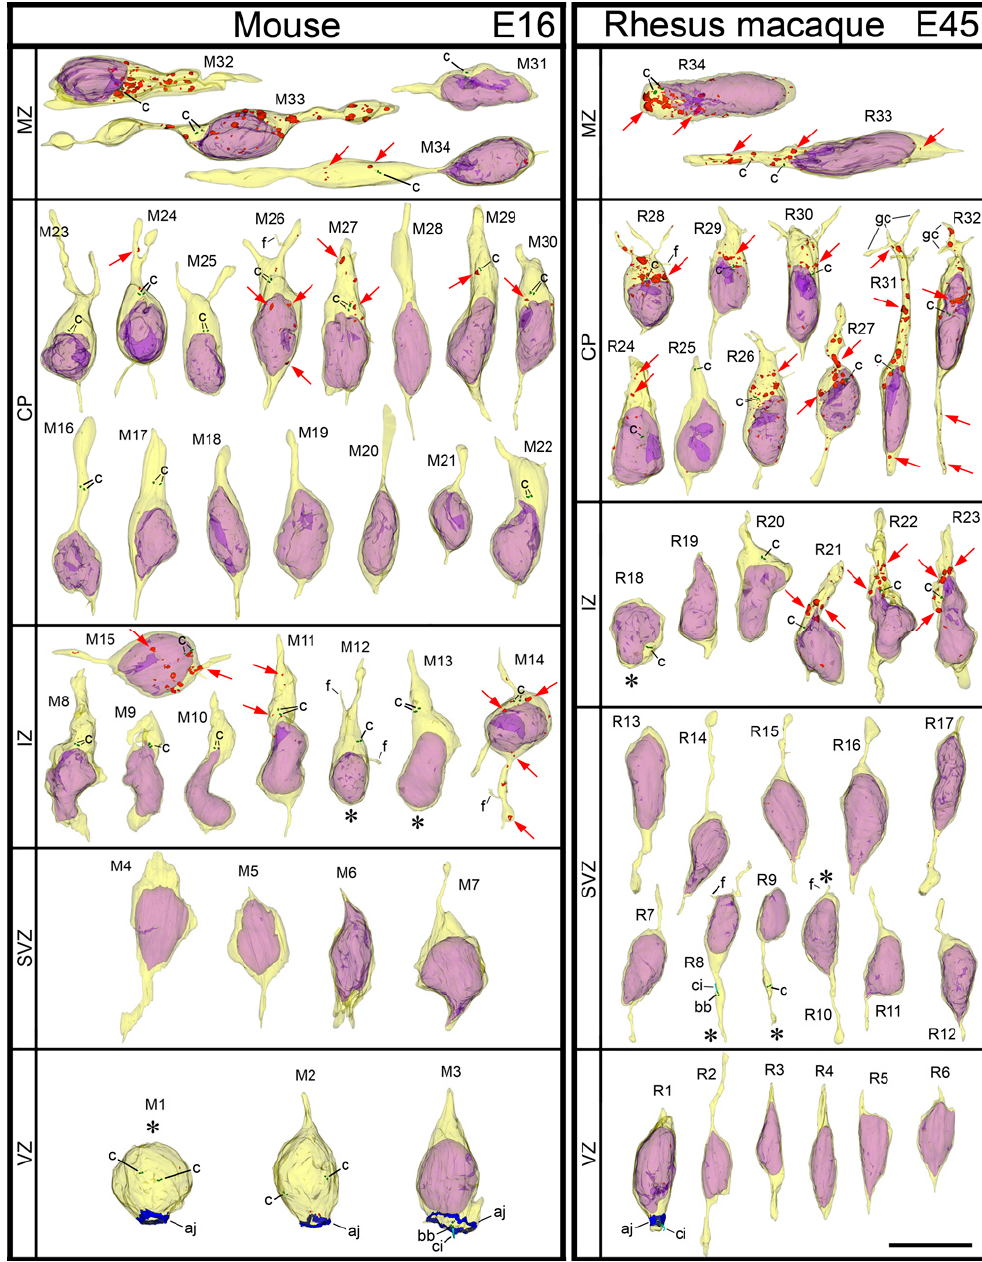
Figure 10. Montage of 3D reconstructed cells from indicated neocortical zones of E16 mouse and E45 rhesus macaque embryos. The cells are placed with pia-directed segments up and the segments facing ventricular surface down. Reconstructed cell bodies with proximal segments of processes are shown as semitransparent yellow, and nuclei are semitransparent violet. Nuclei are absent from mitotic cells while chromosomes in them are not shown. Most of the identified processes are incompletely reconstructed because of truncation in the serial sections. Short processes or cell body segments indicated with asterisks are terminated in the analyzed serial sections. Belts of adherens junctions (aj) connecting the cells at the ventricular surface are shown in blue. Bipolar shape of the cells and centrioles (c; depicted green) located in the leading processes designate radial migration of the cells. CB 1 R-L31 immunoreaction end-product depositions are shown red and some of them also pointed with red arrows. Notice gradual upregulation of CB 1 R while the cells progressively relocate towards CP. Most of the interneurons tangentially migrating through MZ show high CB 1 R content. Primary cilia (ci) are shown as light blue. Indexes of the cells correspond to Supplementary Table S1 that qualitatively and quantitatively characterizes each cell. The scale bar (10 µ m) is valid for all the cells. Abbreviations: bb, basal body; dc, daughter centriole; f, filopodia; gc, growth